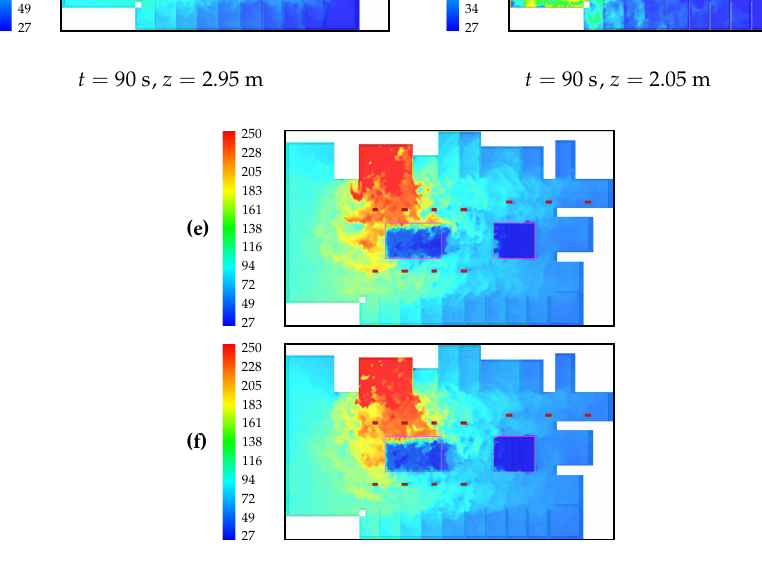
10 and the 10 and ≈ ≈